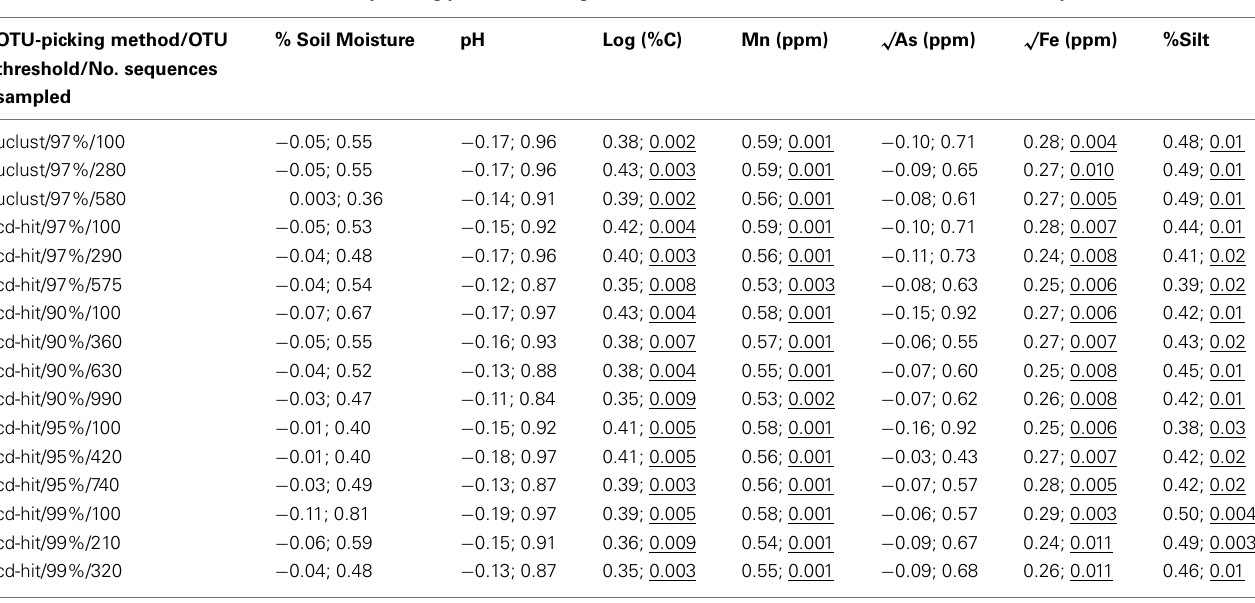
TableA2 | Results from Mantel tests evaluating the relationship between bacterial community structure (UniFrac) and environmental variables. Mantel r statistic and corresponding p -value, unweighted UniFrac vs. environmental variables ( r Statistic; p